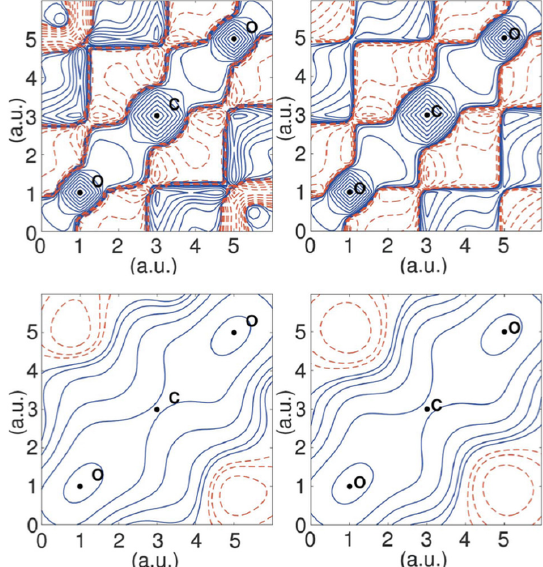
Figure 3. Spin-traced one-particle reduced density matrix (1-RDM) ˆ Γ ( r , r (cid:48) ) contour maps for two different segments [since the 1-RDM is a six-variable function, no convenient graphical representation exists apart from restricting the variation of the two position vectors of ˆ Γ ( r , r (cid:48) ) along a path]. For each segment, the position vectors r (horizontal axis) and r 0 (vertical axis) are restricted to vary along the segment. Upper panel: along the O—C—O bonding. Lower panel: along a segment parallel and 1 a.u. away from the O—C—O bonding. Left column: inferred from position and momentum space expectation values. Right column: periodic ab initio computation. Contours at intervals of ± 0.01 × 2 n a.u. − 3 (n = 0–20): positive and negative contours are blue solid lines and red dashed lines, respectively. Reproduced with permission of the International Union of Crystallography from reference [100].